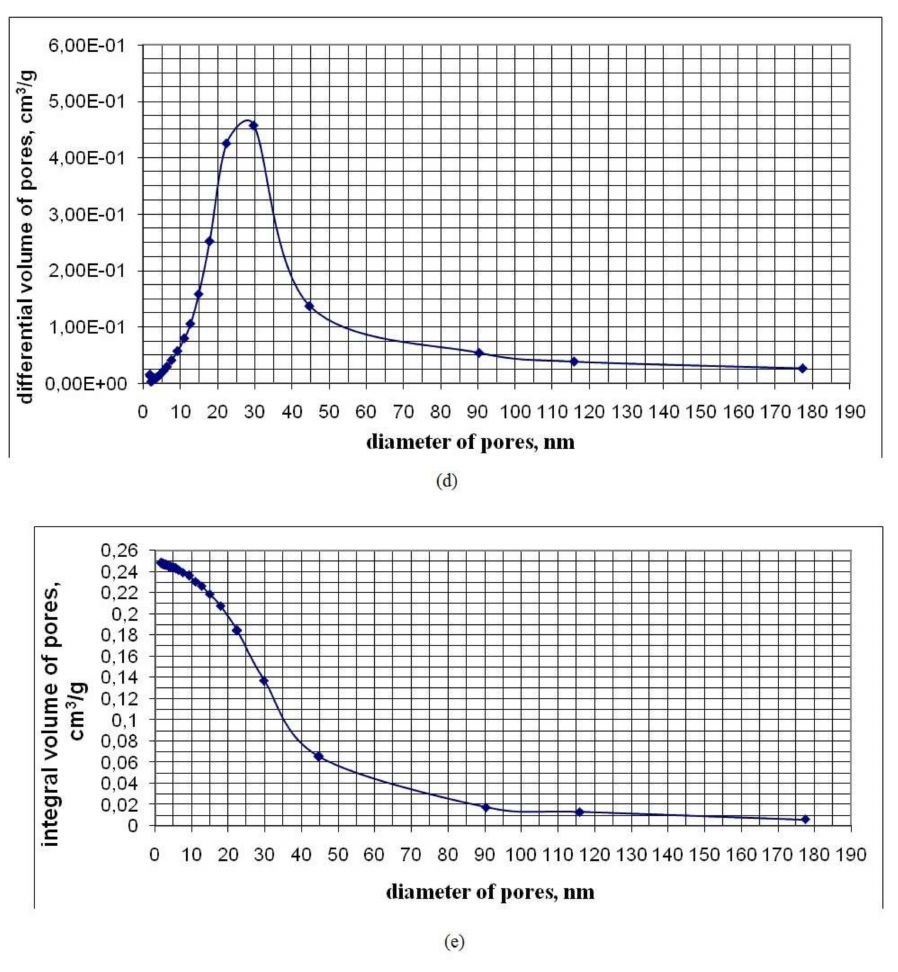
Figure 9. Pore characteristics of the UF-3-8 sample obtained by the low-temperature nitrogen adsorption method: ( a ) adsorption-desorption curves (p / p 0 —relative nitrogen pressure, p 0 —nitrogen saturation pressure at a temperature of 77 K); ( b ) di ff erential distribution of area over pore diameter; ( c ) integral distribution of the area along the pore diameter; ( d ) xi ff erential distribution of volume over pore diameter; ( e ) integral distribution of volume by pore